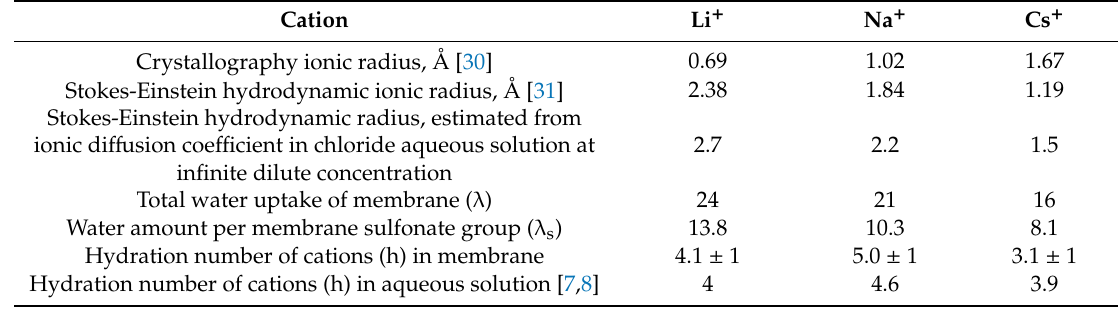
Table 2. Crystallography radii, Stokes–Einstein hydrodynamic ion radii, and hydration numbers (h) of Li + , Na + , and Cs + cations in appropriate MSC membrane ionic forms at RH = 95% and in equimolar aqueous salt chloride solutions.